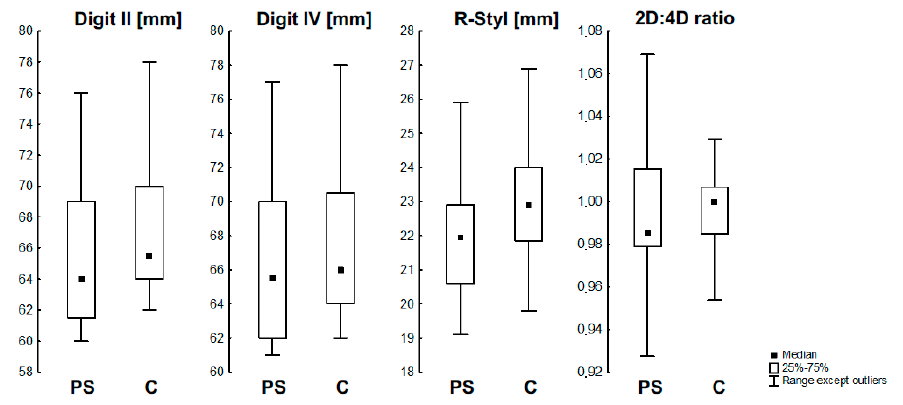
Figure 3. The distribution of measured parameters between groups. Table 1. Comparison of hand parameters between affected and nonaffected sides in patients with Poland syndrome.